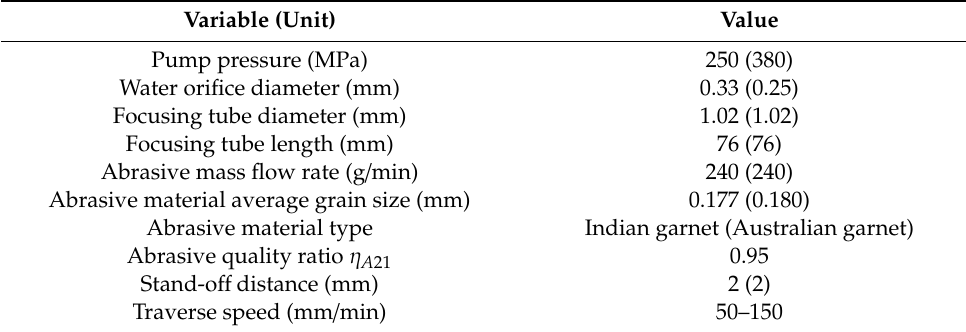
Table 3. Summary of factors and parameters used for experiments in Kielce and the values used for determination of the original limit traverse speeds v P lim1 in Ostrava (in brackets).